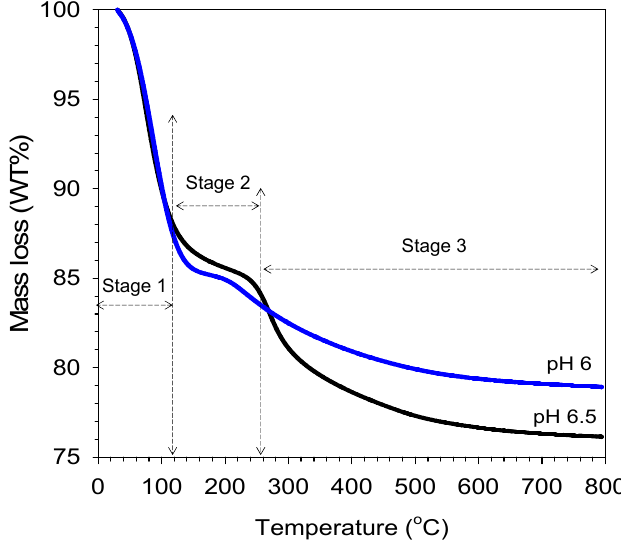
Figure 8. TGA mass loss curves of organo-silica xerogel in varied pH as function of temperature exposed.